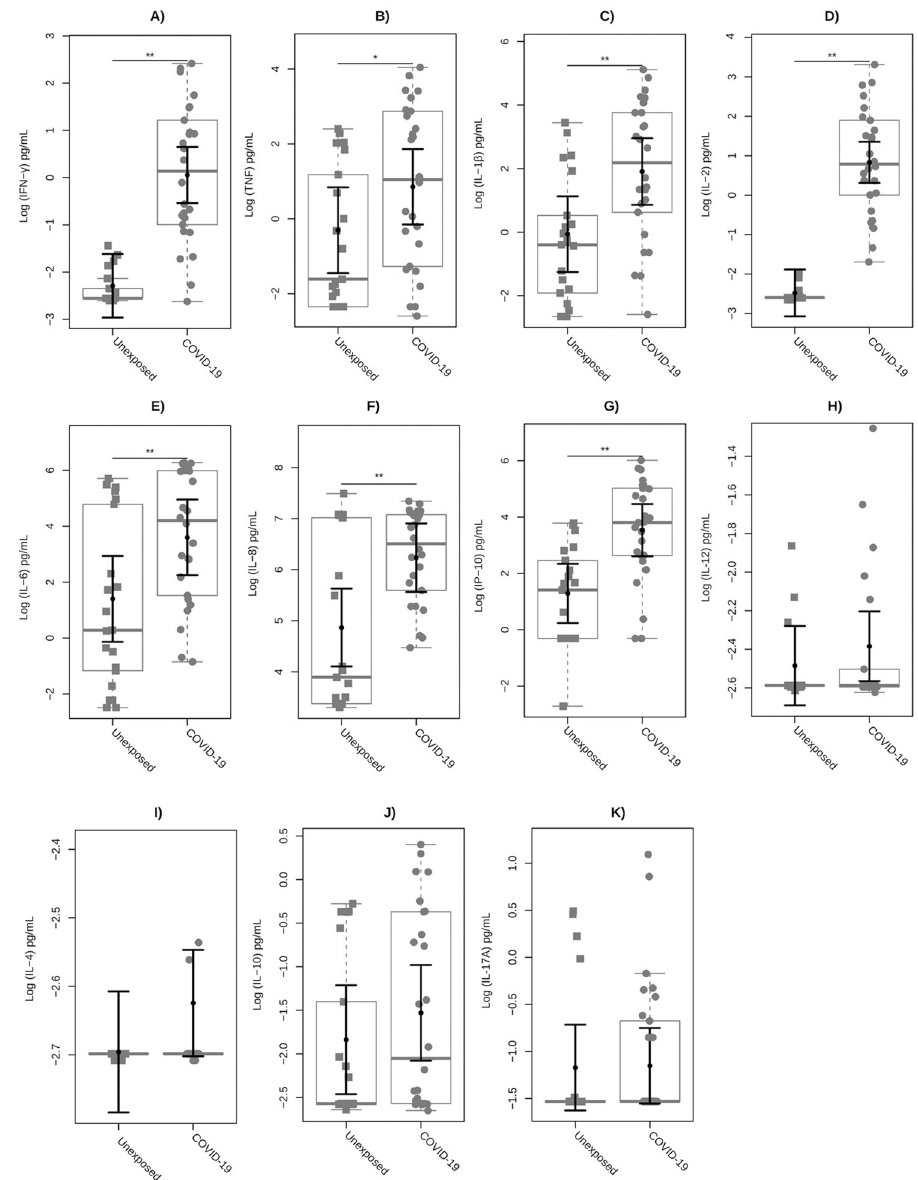
Fig 3. Plasma cytokine profile by SARS-CoV-2 Spike protein stimulation in whole blood CRA test. The cytokines (A) IFN- γ , (B) TNF, (C) IL-1 β , (D) IL-2, (E) IL-6, (F) IL-8, (G) IP-10, (H) IL-12, (I) IL-4, (J) IL-10, and (K) IL-17A were evaluated. The levels obtained from each inflammatory mediator were analyzed on a logarithmic transformed scale and illustrated using box plots to compare unexposed and COVID-19 groups. Squares represent individuals in the unexposed group, solid circles represent individuals in the COVID-19 group, and the box plots represent the interquartile range and the sample median (solid gray centerline). The larger black solid circles and central bars represent the fitted means estimated by the linear model, and the marginal mean values and their upper 95% confidence intervals were estimated for both unexposed individuals and for COVID-19 controlled for sex, BMI, and age for IFN- γ and PHA (mitogen) after stimulation with a specific biomarker for SARS-CoV-2 S protein. ** , P < 0.01; * , P < 0.05.